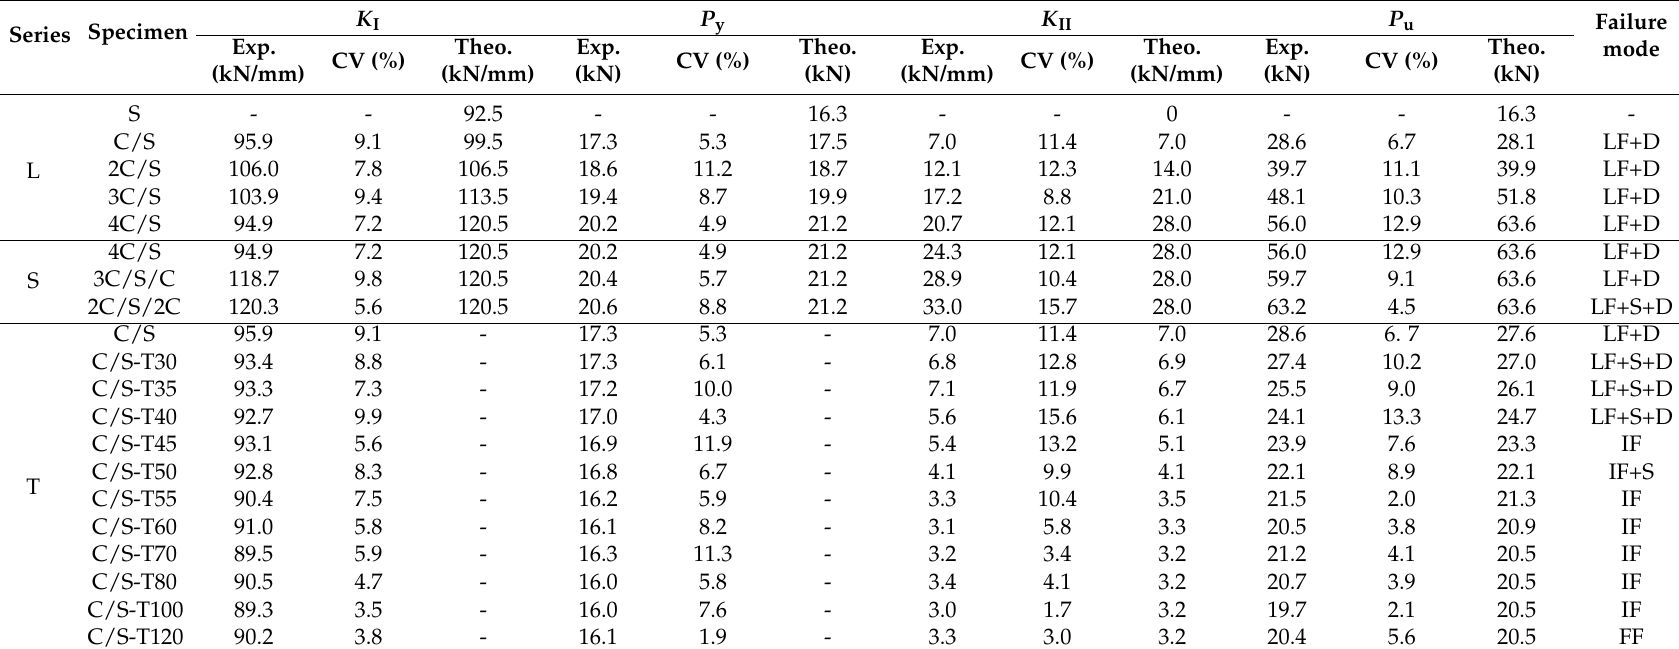
Table 3. Test results of specimens at ambient